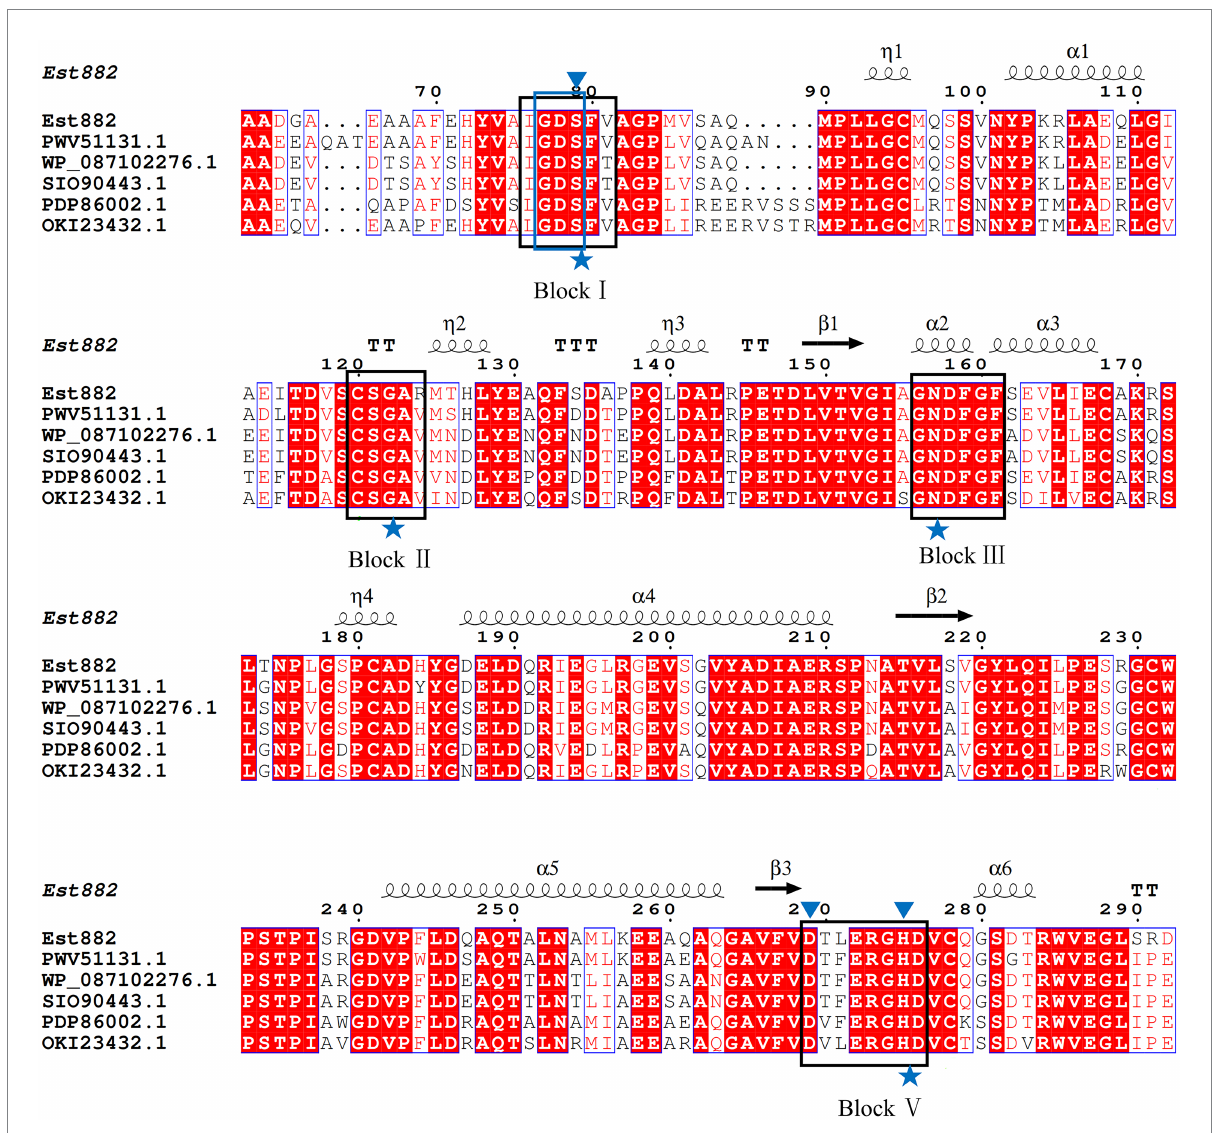
FIGURE 1 Alignment of multiple amino acid sequences of Est882 and its homologues. Black rectangles: the four conserved domains (blocks I, II, III and V) of Est882. blue asterisks: the four constant important catalytic residues Ser-Gly-Asn-His in the conserved blocks. Blue rectangle: the conserved GDS(X) motif. Blue triangle: the amino acids (Ser79, Asp269 and His275) that make up the catalytic